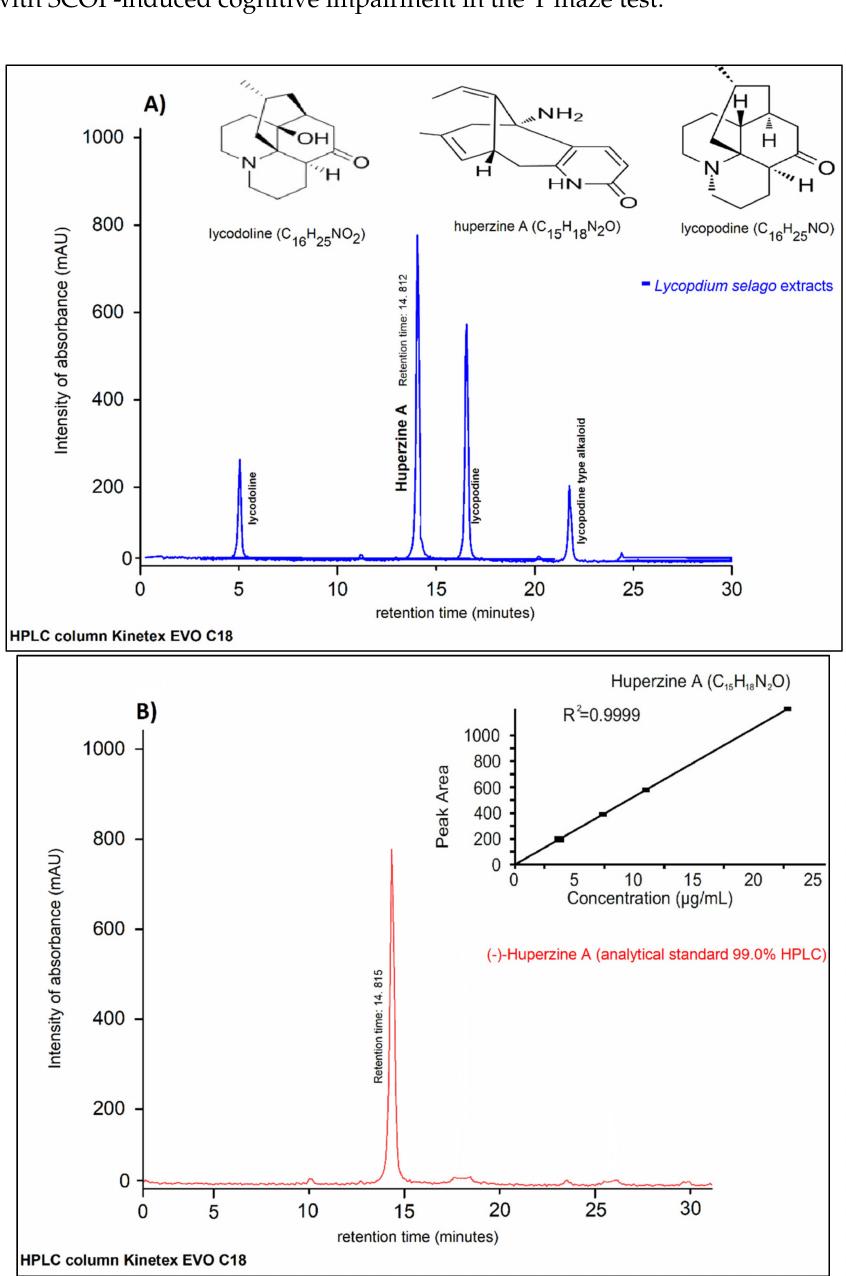
Figure 3. The HPLC sample chromatogram of HupA. The retention time of sesquiterpene alkaloid HupA peak remained within the range of 14.812–14.813 min ( A ) as the HupA molecule standard ( B ), at 14.815